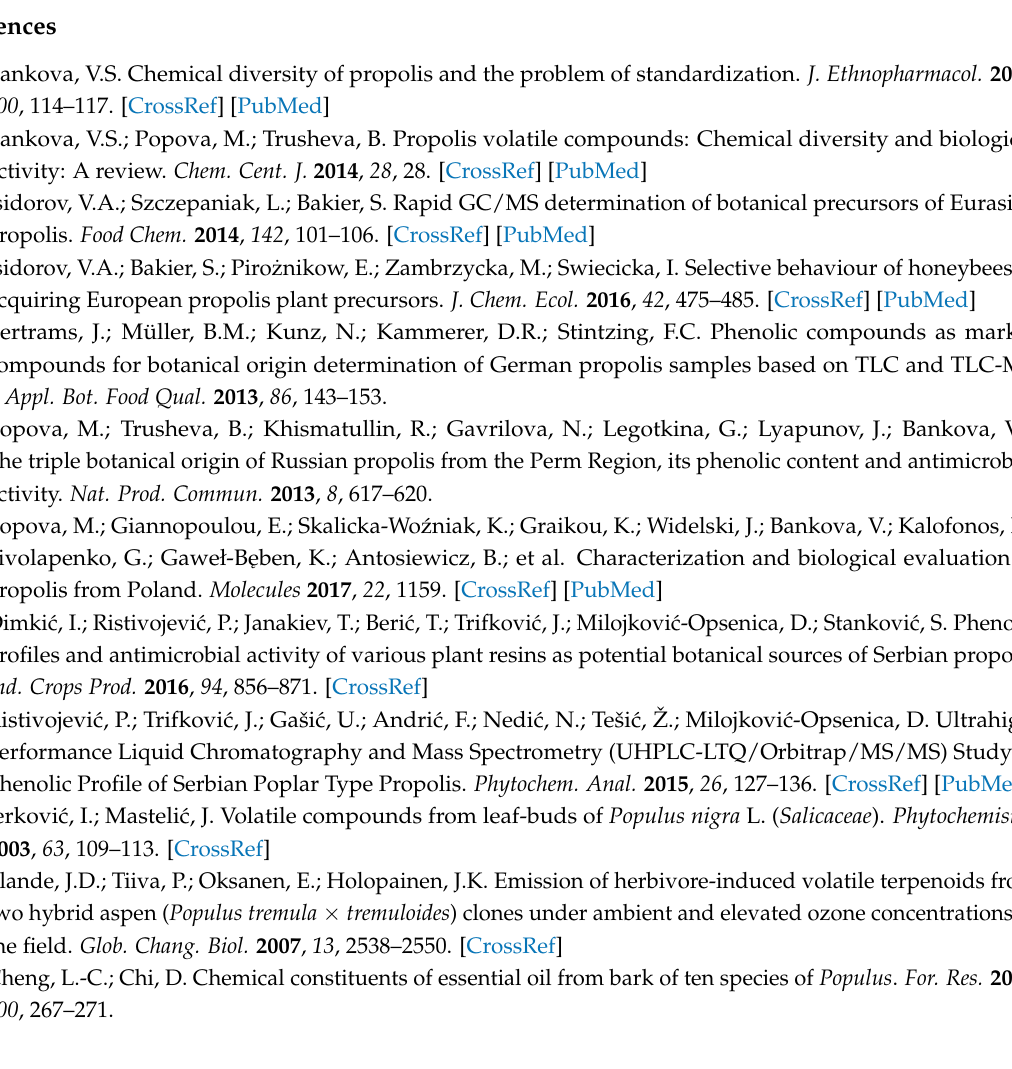
Supplementary Materials: The following are available online, Supplement Table S1A–H: Full results of GC-MS analysis of Populus spp. buds essential oils, Supplement Table S2A–G: Full result of GC-MS analysis of Polish propolis essential oils, Supplement Table S3A–H: Full result of GC-MS analysis of Polish propolis essential oils, Supplement Table S4A–E: UPLC-DAD-MS identification of 70% ethanol in water extracts composition, Supplement Table S5A–E: Composition of Populus spp. buds 70% ethanol in water extracts, Supplement Table S6A–E: Composition of Polish propolis 70% ethanol in water extracts, Supplement Table S7A–E: Composition of Canadian, German and Polish propolis 70% ethanol in water